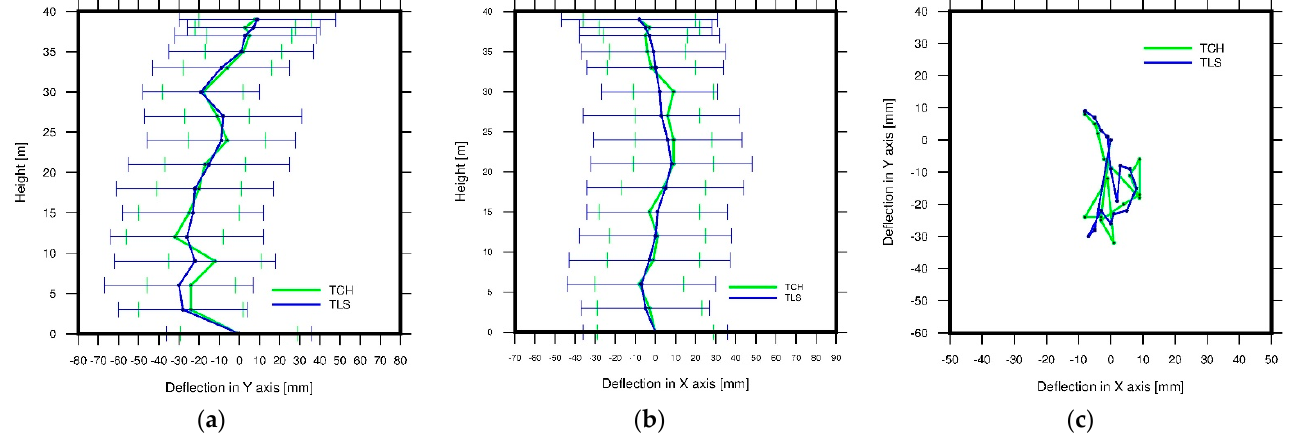
Figure 6. Deflection graphs of the cooling tower: ( a ) in the YZ axis, ( b ) in the XZ axis, ( c ) in the XY axis. In XZ and YZ, axis vectors are depicted with an error bar in millimeters.